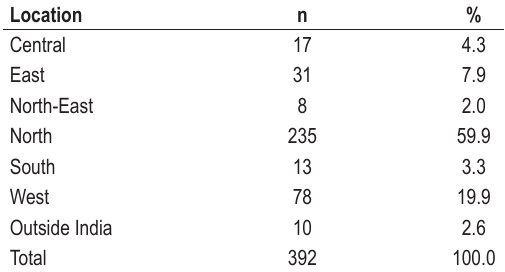
TABLE 1. Participants geographical